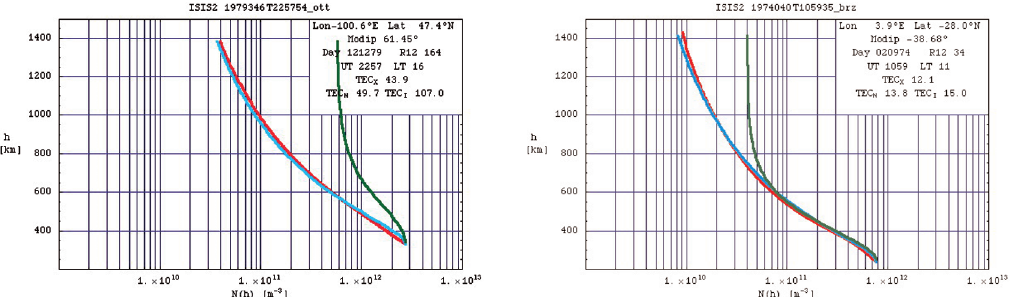
Fig. 1. Examples of comparisons among electron density topside profiles. Red curves correspond to ISIS 2 ex- perimentally derived profiles. Green corresponds to IRI-2000 profiles and light-blue are NeQuick 2